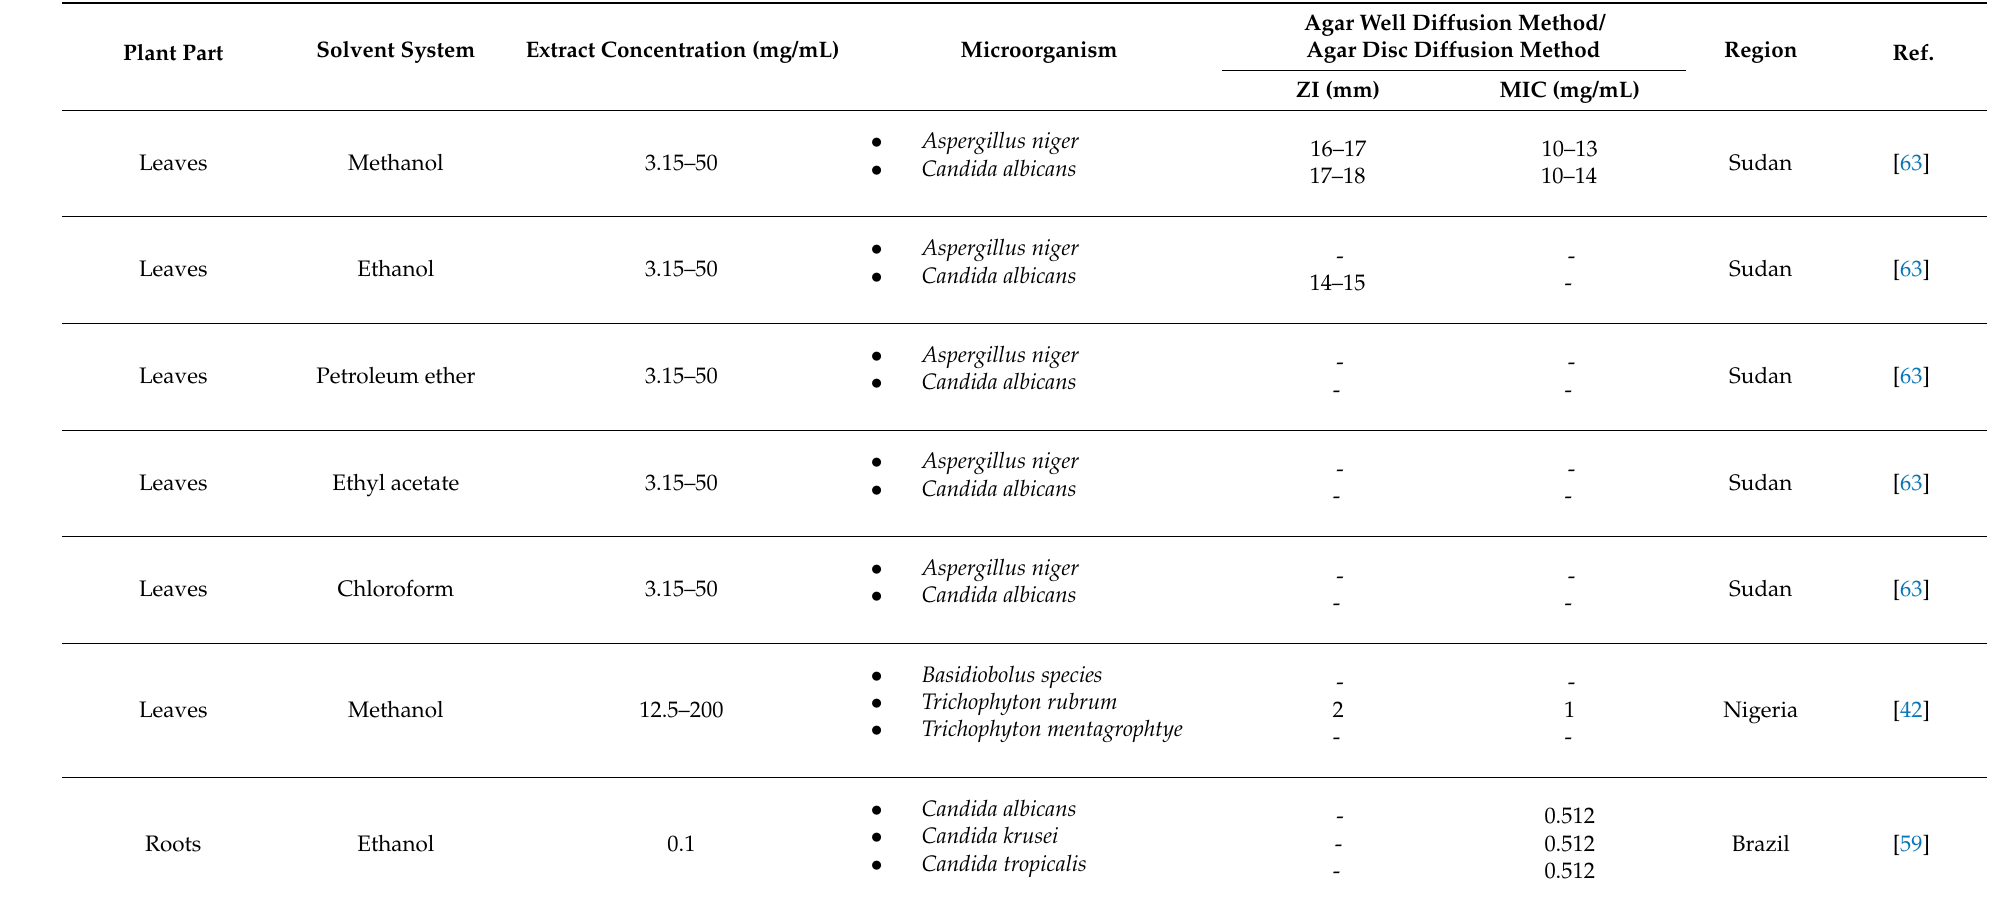
Table 10. Antifungal activity of Cajanus cajan